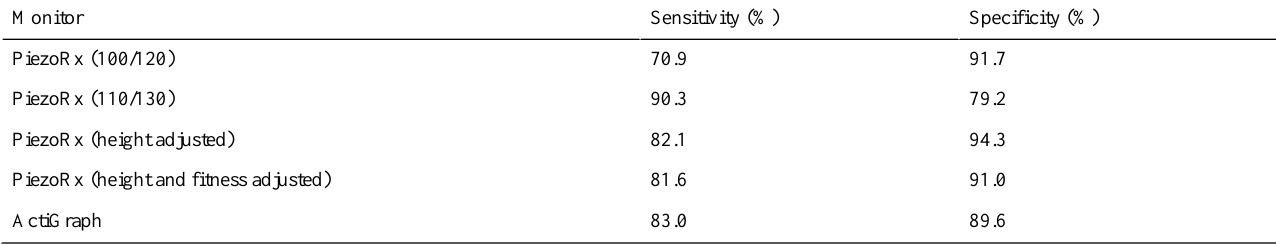
Table 6. Sensitivity and specificity rate of each activity monitor in measuring moderate-to-vigorous physical activity.